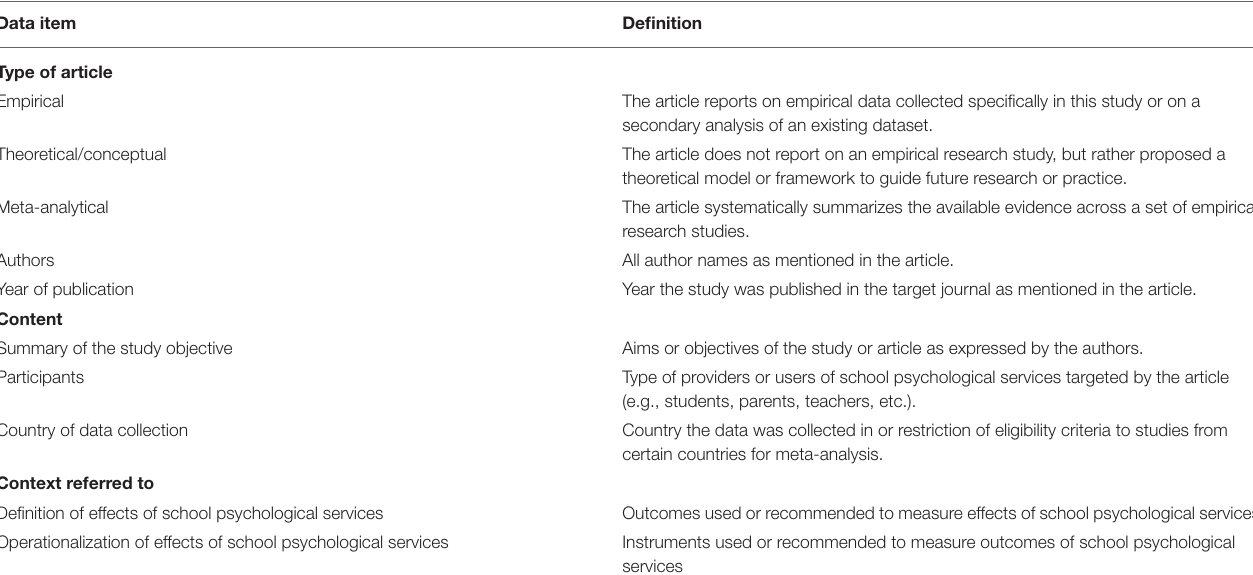
TABLE 1 | Definitions of data